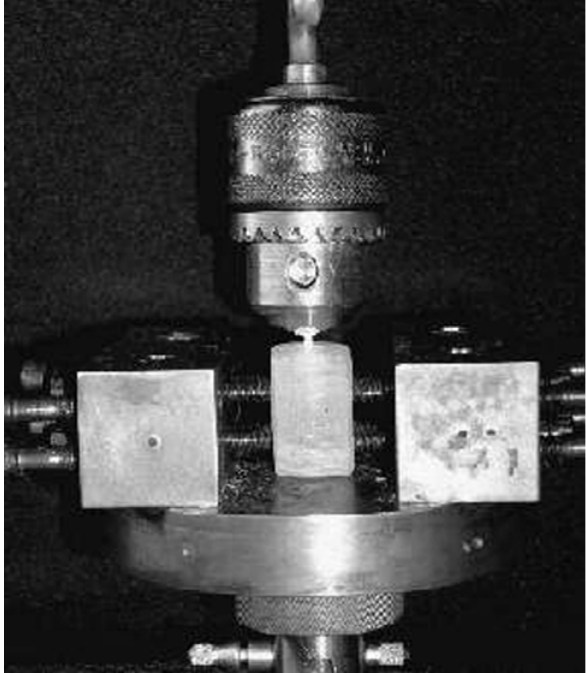
FIGURE 2- Specimen positioned in the universal testing